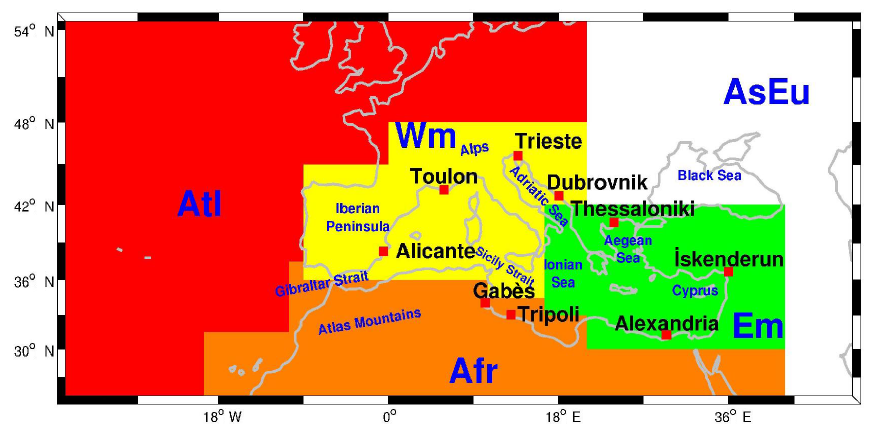
Figure 1. The Mediterranean region with the coastal stations considered in this study (starting from the west in clockwise direction along the coastline): Alicante, Toulon, Trieste, Dubrovnik, Thessaloniki, ˙Iskenderun, Alexandria, Tripoli, Gabès. The figure also shows the areas considered for classifying the cyclogenesis that produces sea level anomalies in the Mediterranean region: Atlantic (Atl), Africa (Afr), western Mediterranean (WM), eastern Mediterranean (EM), and Asia–Europe (AsEu). Finally, the geographical names used in the text are annotated in the